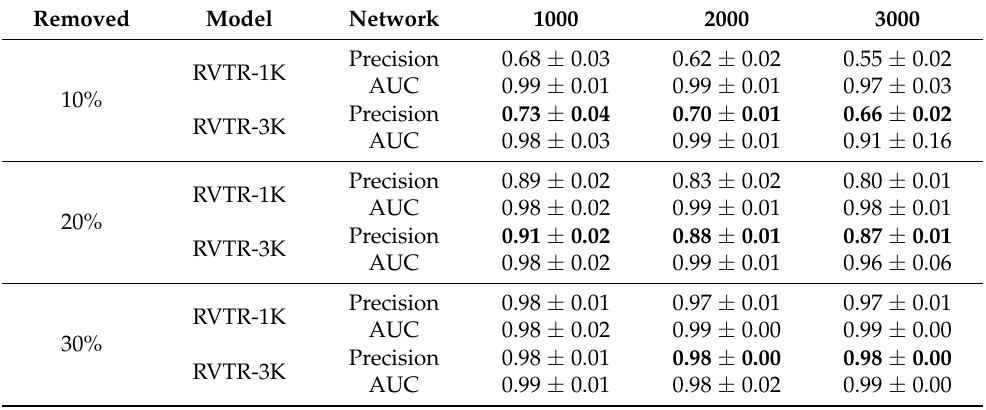
Table 5. The prediction results of two RVTR models that were tested on different sized networks with 10%, 20% and 30% nodes removed,